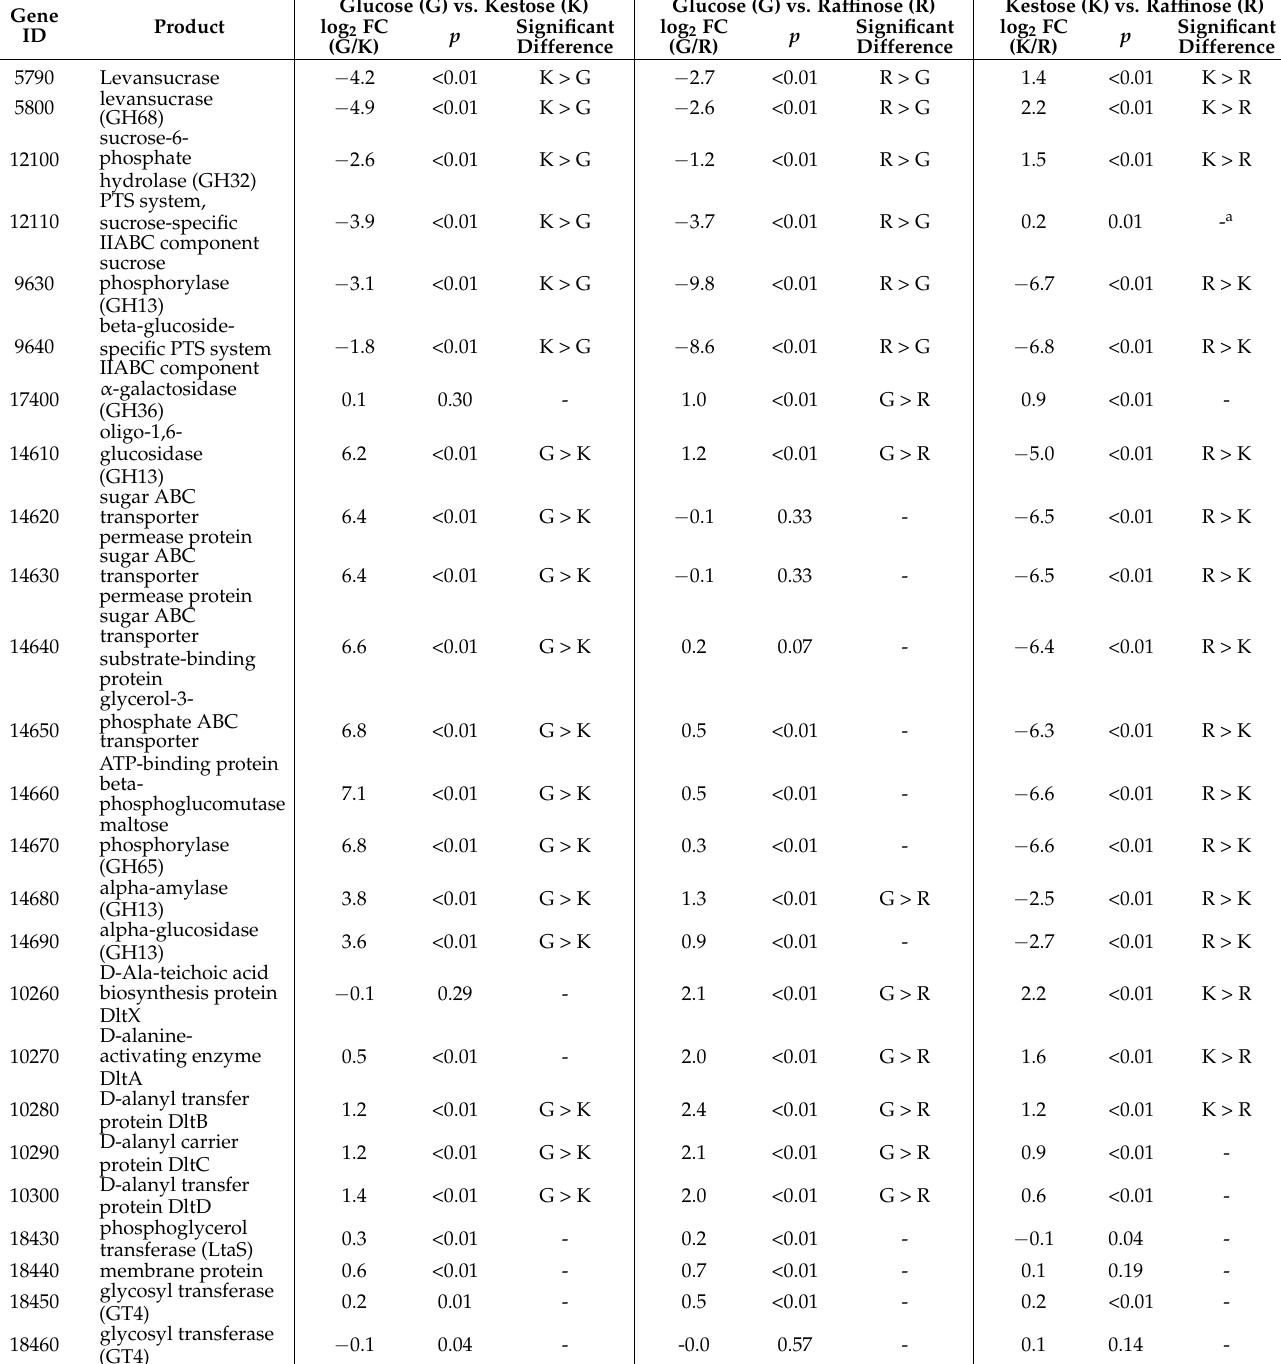
Table 4. Comparison of gene expression levels in L. paragasseri JCM 11657 cells in the presence of different